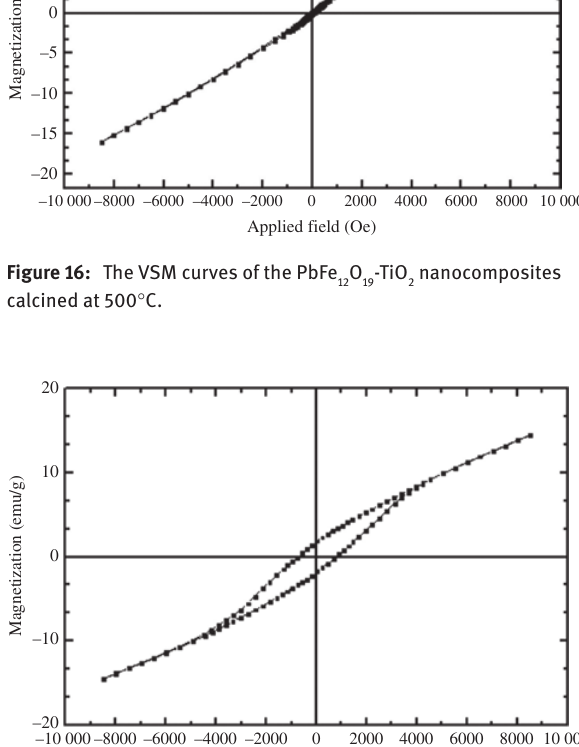
Figure 17: The VSM curves of the PbFe calcined at 800 ° C.